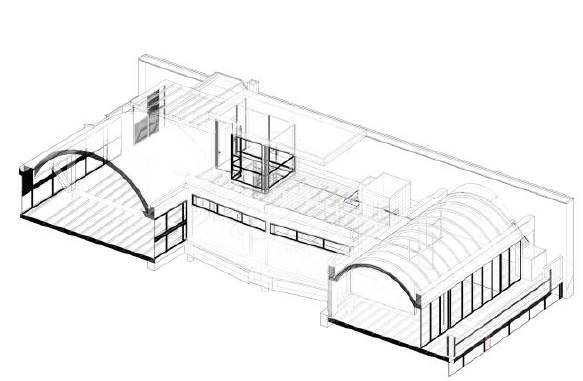
Figure 11. Numerical structure model Thermal simulation